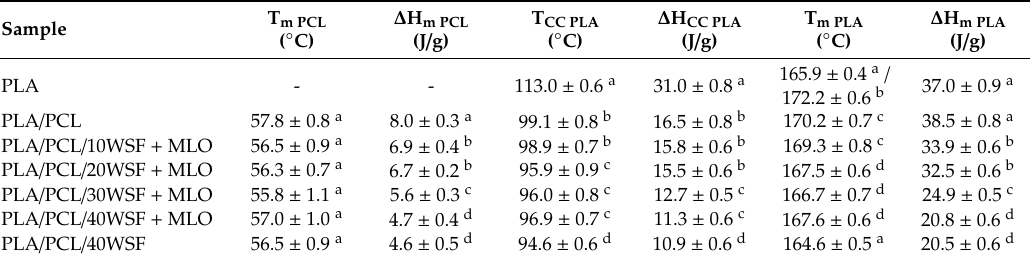
a–d Di ff erent letters in the same column indicate a significant di ff erence among the samples ( p <